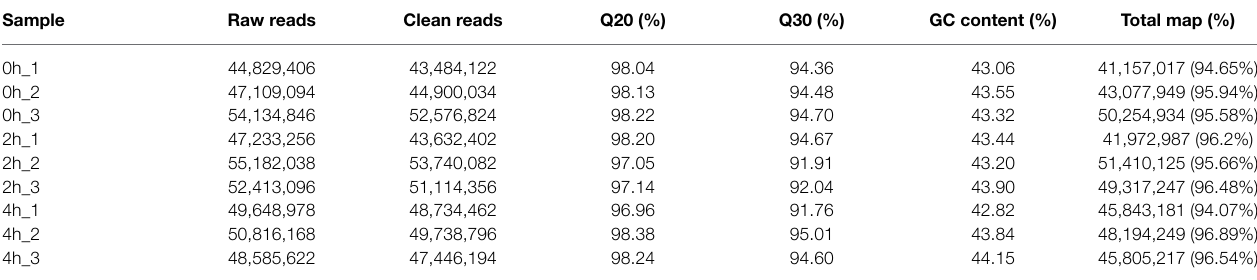
TABLE 1 | Transcriptome sequencing quality assessment.